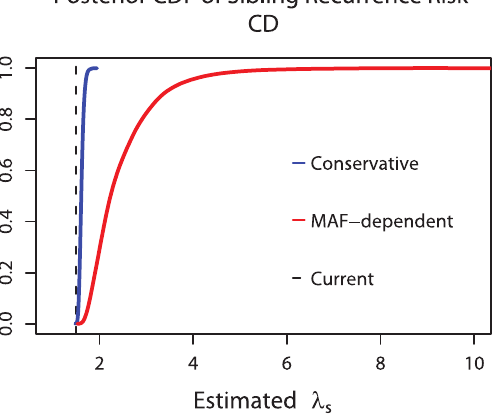
Figure 4. Adjusted estimates of explained heritability. Cumu- lative density functions of the posterior distribution of estimated sibling recurrence risk ratio (estimated l S ) in breast cancer (BC), Type 2 diabetes (T2D), and Crohn’s disease (CD) under the conservative and MAF-dependent priors. The dotted line indicates the l S based on replicated loci in each of the three diseases. The quoted values of sibling recurrence risk ratio (lower right hand corner) are from references given in main text. Posterior distributions were calculated assuming a GWAS of 5,000 cases and controls and a replication study of 10,000 cases and